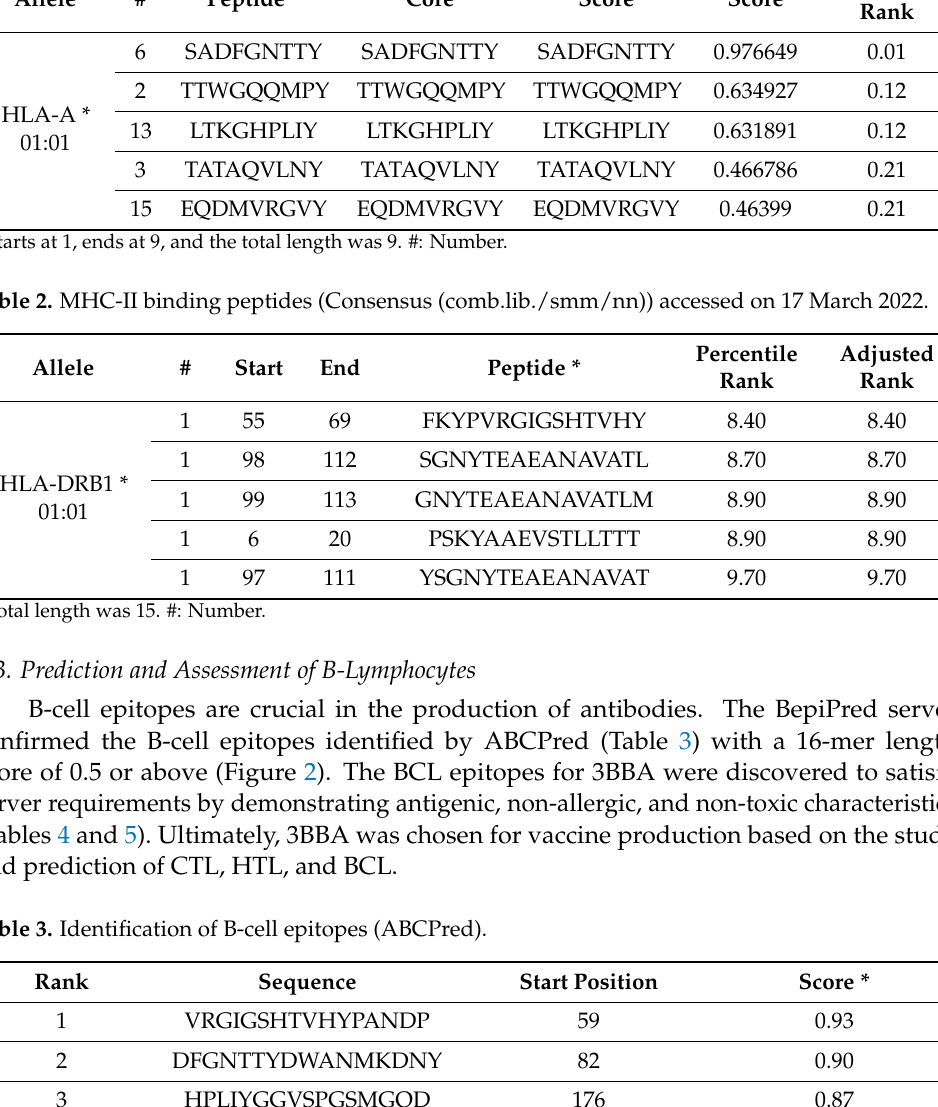
Table 1. MHC-I binding predictions of IEDB server. Allele